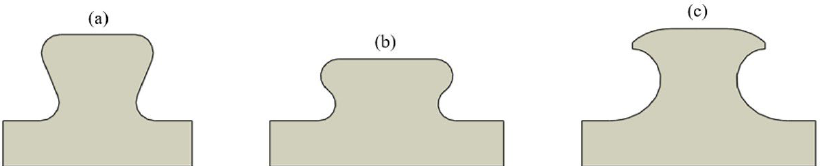
Figure 1. Composite dowel shear connection geometries: (a) Crestbond (CR); (b) Puzzle (PZ) and (c) Clothoidal (MCL).